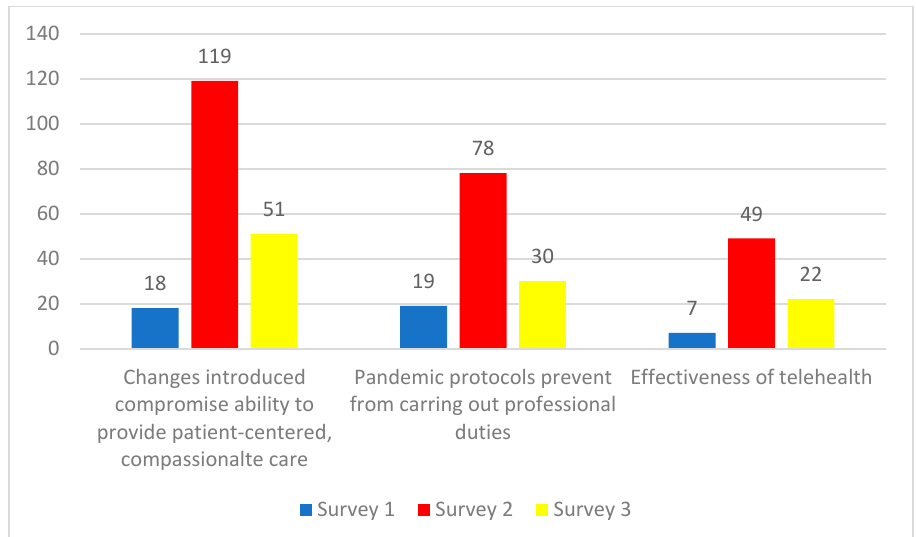
Figure 3. Number of responses corresponding to theme 1: HCWs’ capacity to serve patients. Since participants could select multiple themes, it is not possible to calculate percentages.